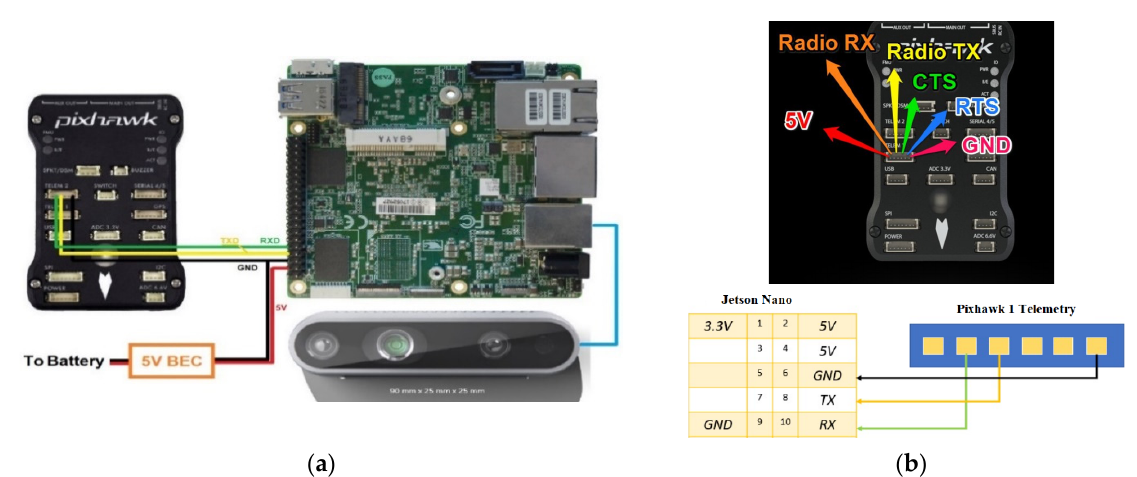
Figure 5. Descriptions of the connections of the pixhawk to the camera and the companion computer: ( a ) connections of the tracking camera to the companion computer and Pixhawk board; ( b ) telemetry pins on the pixhawk.